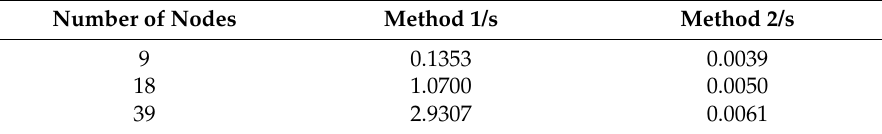
Table 5. Comparisons of computing time for three different benchmarks.